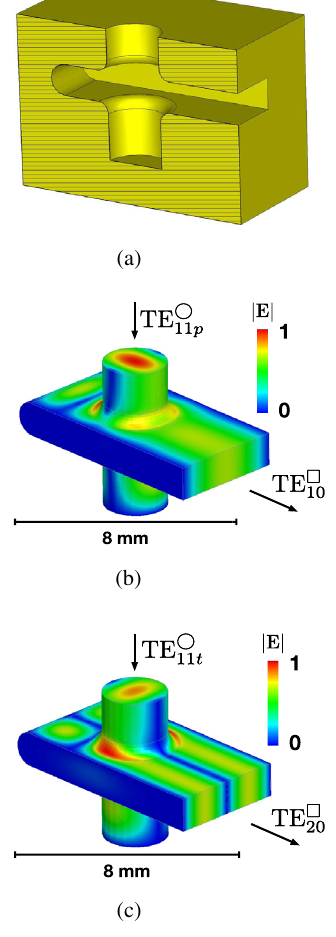
FIG. 16. TE ○ 11 -to-TE □ 10 = TE □ 20 mode converter, adapted from Toufexis et al. [23]. (a) Metallic surface, (b) surface electric field for the parallel polarization, and (c) surface electric field for the transverse polarization.